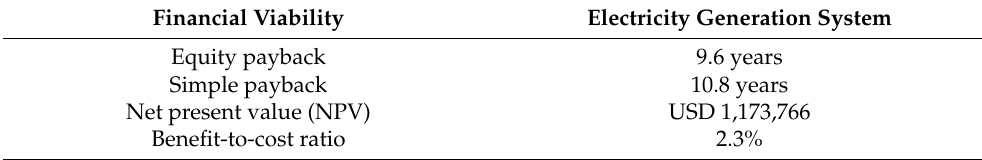
Table 8. Project financial output parameters for an annual electricity rate of 0.1 USD/kWh.